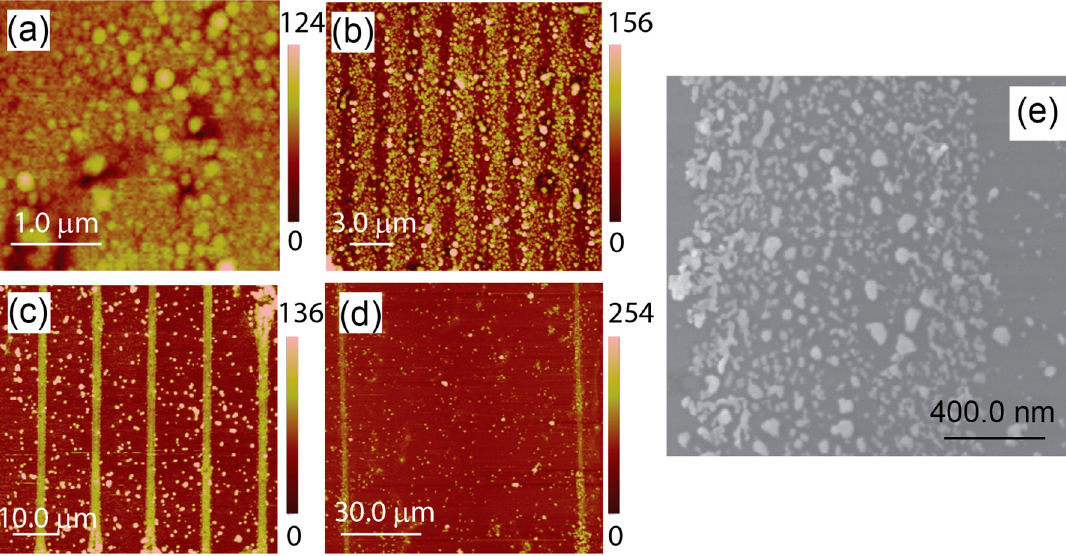
Figure 2. Atomic force microscopy images of GNPs with period of ( a ) 0.5 µ m; ( b ) 2 µ m; ( c ) 10 µ m; ( d ) 100 µ m; ( e ) SEM image of GNPs distributed in one stripe.